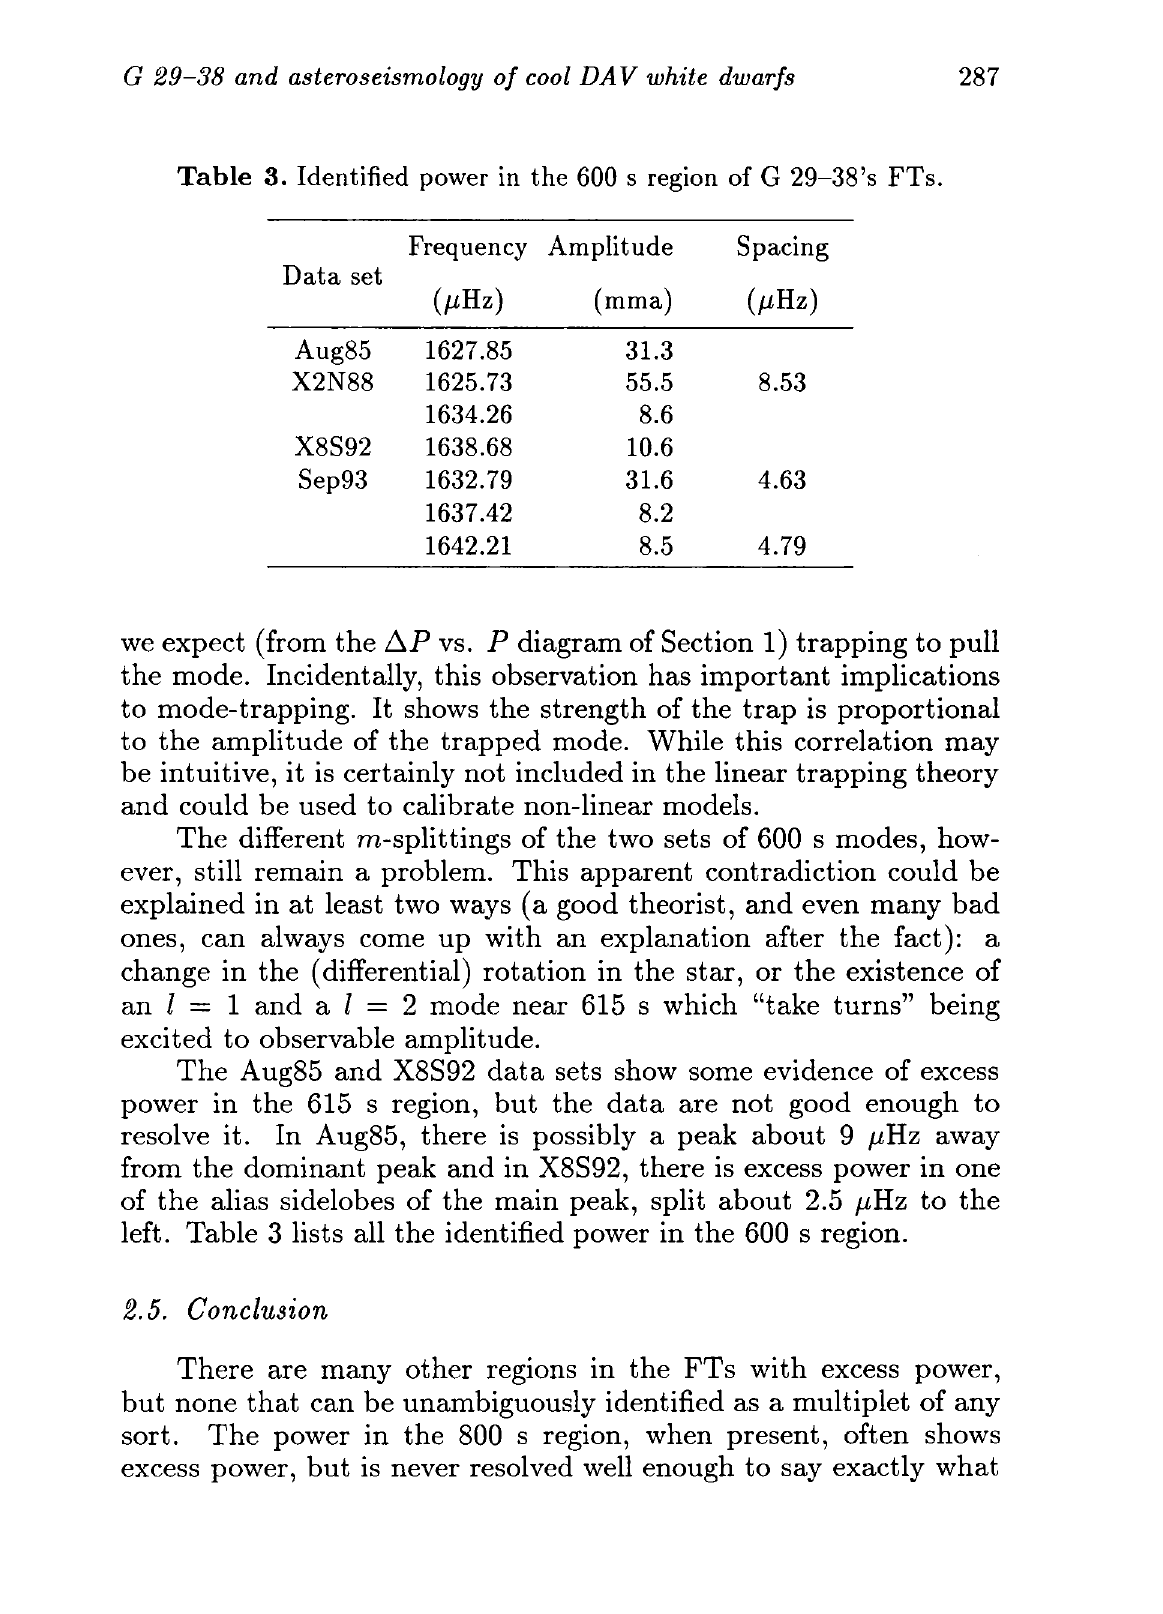
Table 3. Identified power in the 600 s region of G 29-38's